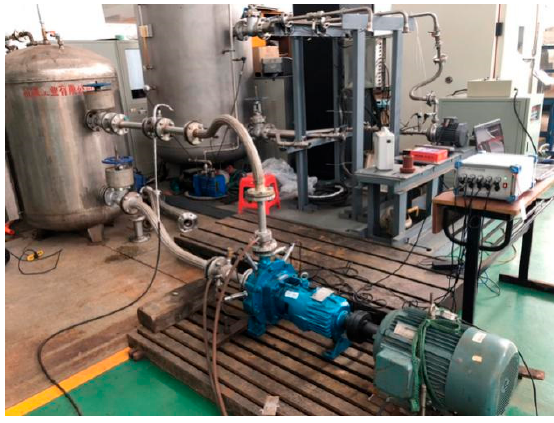
Figure 7. Test bed.